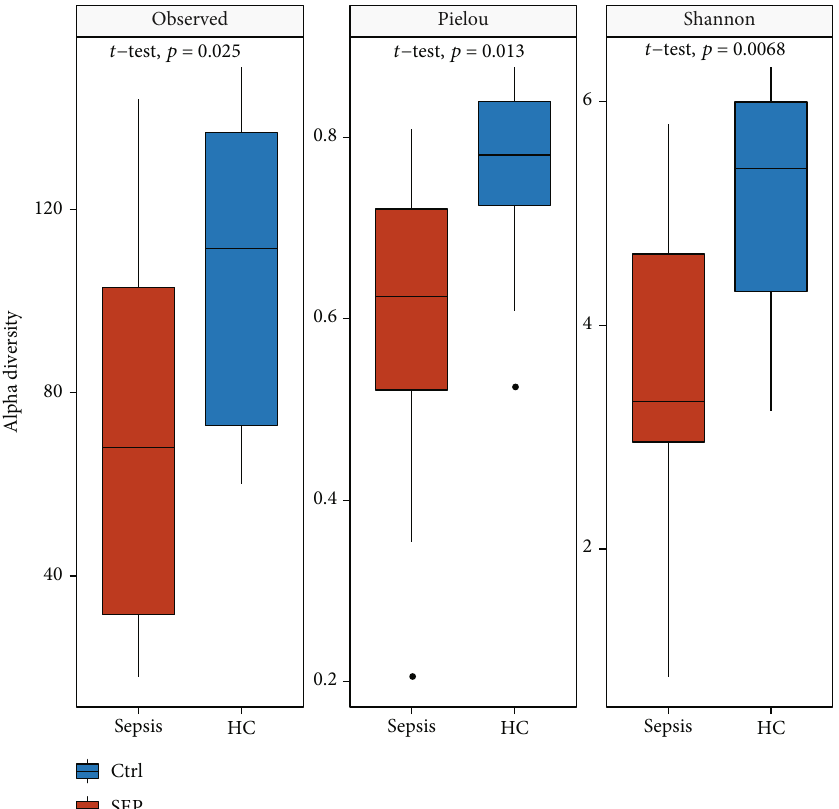
Figure 1: Comparisons of alpha diversity indexes between sepsis (SEP) and healthy control (Ctrl) group. Signi fi cant lower observed feature number, Pielou, and Shannon indexes were observed in patients with sepsis.